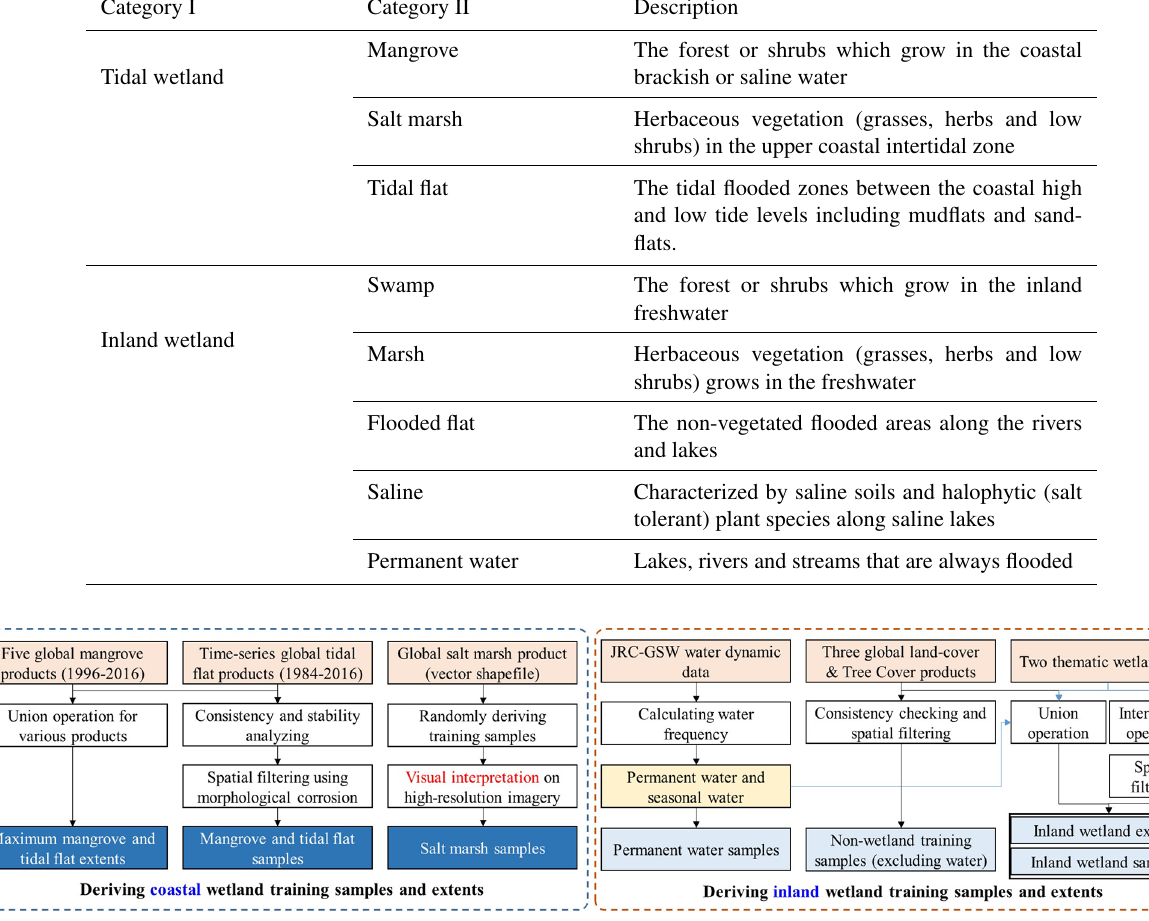
mangroves over the world, so the MaxExtent mangrove can be used as the boundary for mangrove mapping; namely, only the pixel within the maximum mangrove extent was labeled as mangrove